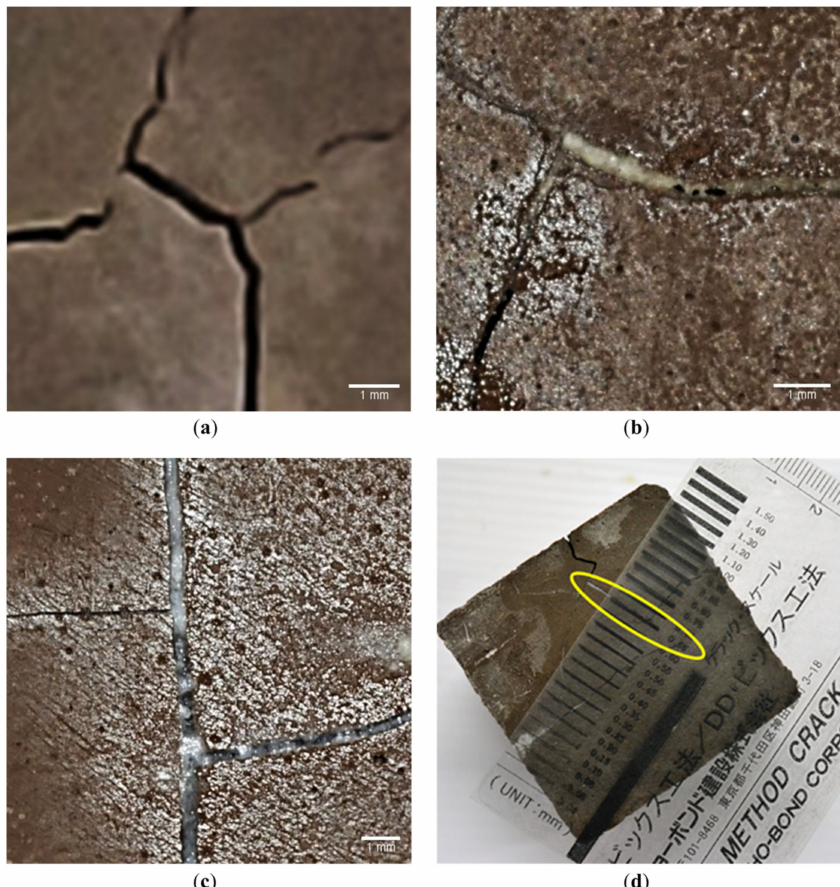
Figure 4. Crack sealing in a geopolymer after 28 healing days: ( a ) Control specimen; ( b ) using pure culture; ( c ) using co-culture; ( d ) maximum crack width